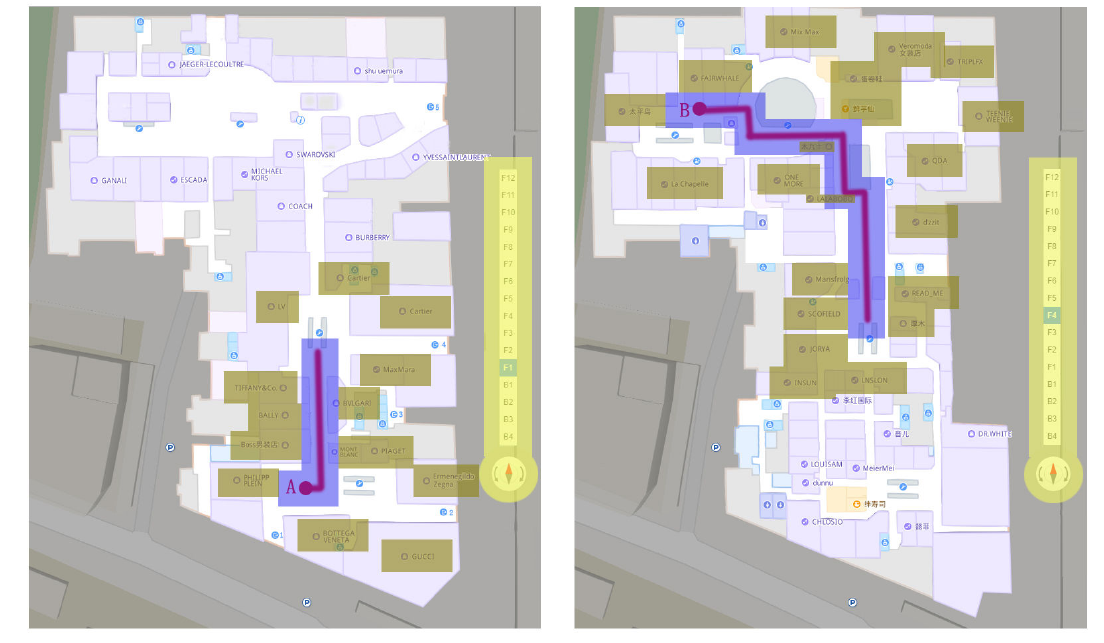
Figure 8. AOI divisions for route